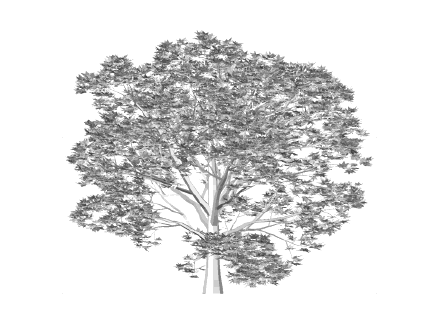
Figure 2. Sample tree model used to simulate the texture of high vegetation.